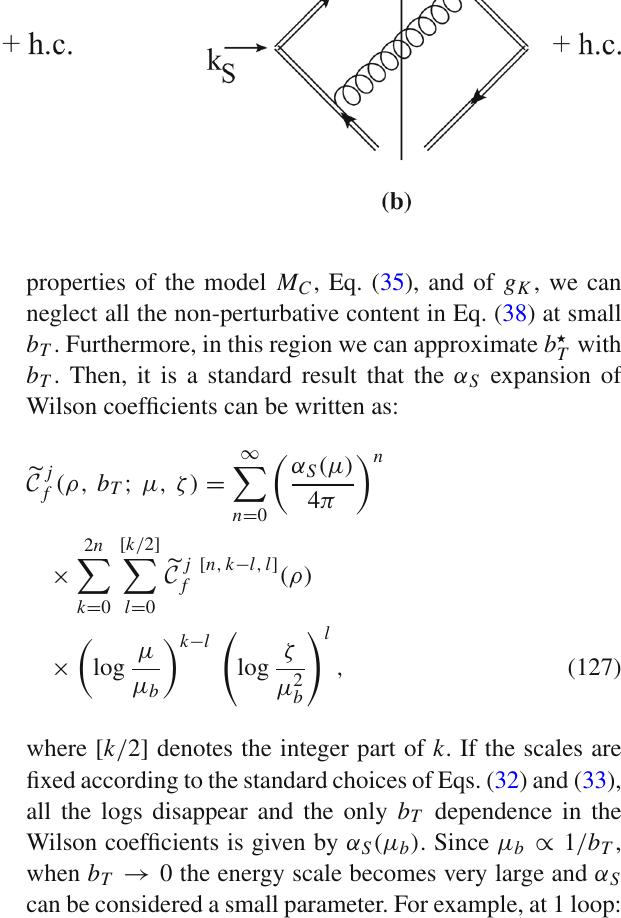
Fig. 12 Feynman graphs contributing to the small b T behavior of the 1 loop soft factor (cid:7) S 2 − h . a Virtual diagrams (zero in dimensional regularization). b Real